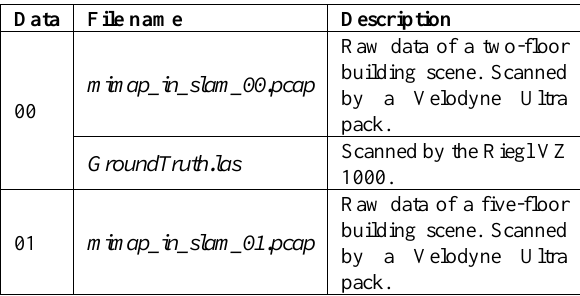
Figure 5. Structure of the indoor LiDAR-based SLAM dataset. Table 1. Data description of the indoor LiDAR-based SLAM dataset.